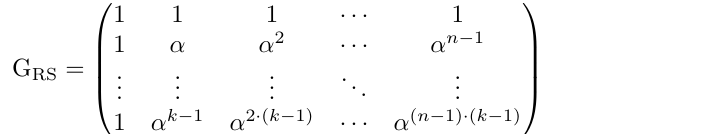
( Y, ˆ Y ) = 1 due to how H | S